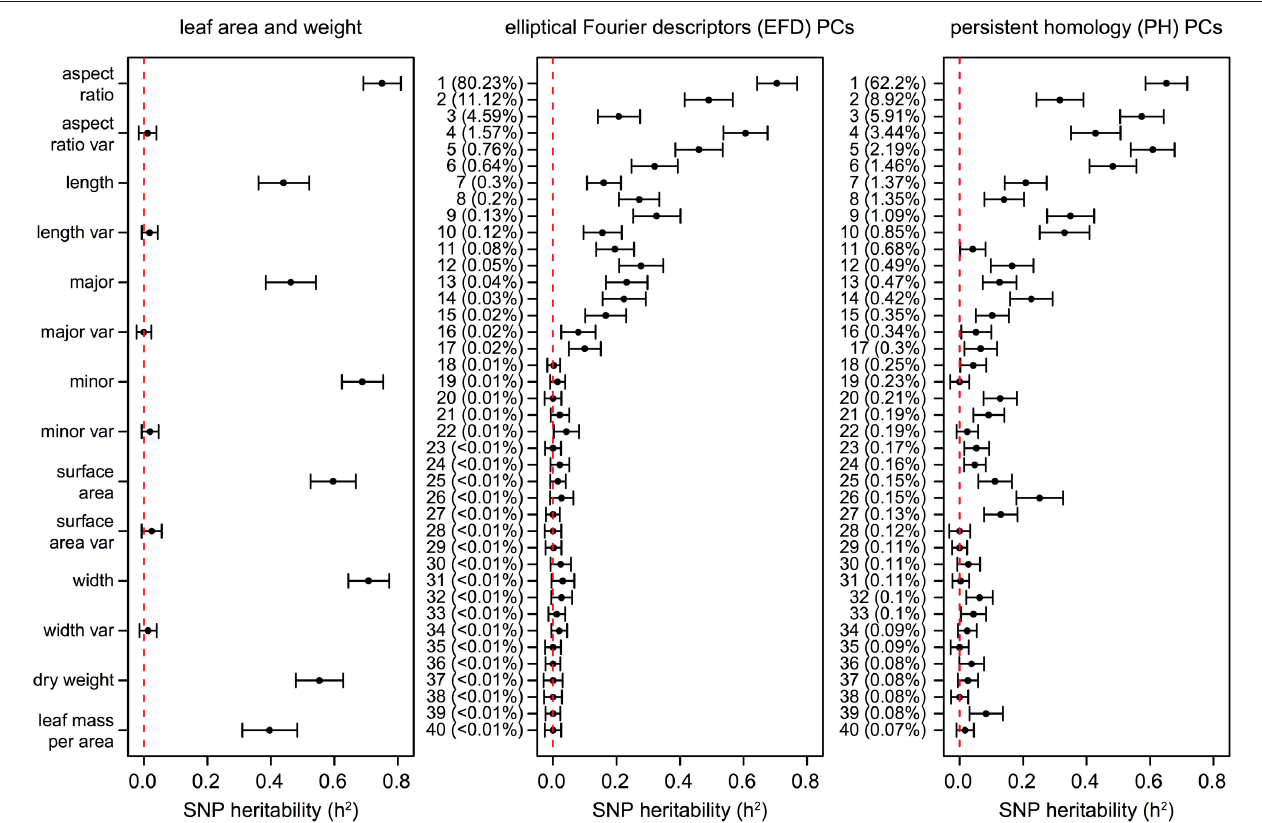
FIGURE 8 | SNP heritability (h 2 ) of leaf phenotypes. Values represent the additive genetic variance (V g ) divided by the phenotypic variance (V p ) with a standard error as calculated using GCTA ( Yang et al., 2011). The dotted lines are found at h 2 = 0, indicating that none of the phenotypic variance is explained by the genetic data. The proportion of the total phenotypic variance explained by each PC is indicated in